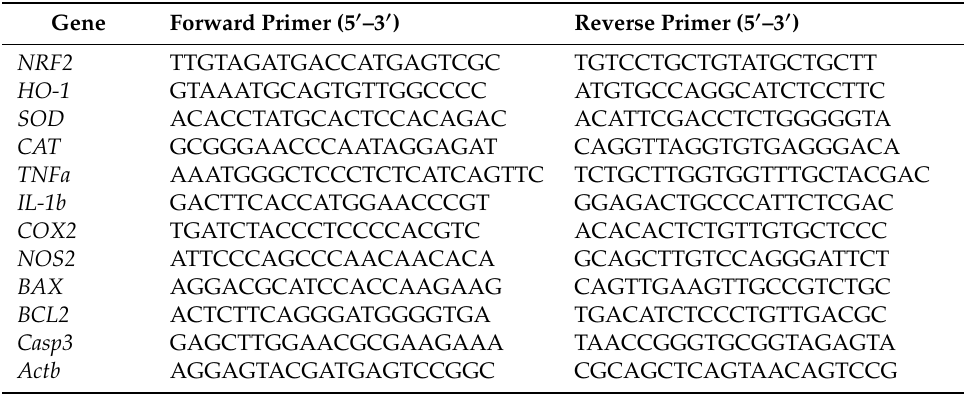
Table 1. Primers used for